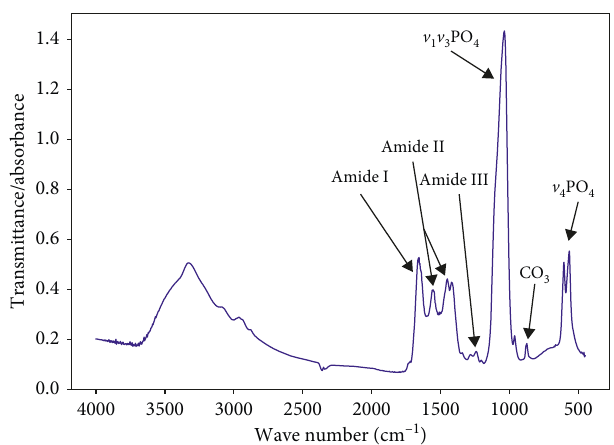
Figure 1: Typical FTIRM spectrum of human bone between the 450cm − 1 and 4000cm − 1 boundary. Amides I, II, and III represent the organic matrix of the bone, while the ] 1 ] 3 PO 4 , ] 4 PO 4 , and ] 2 CO 3 are part of the mineral